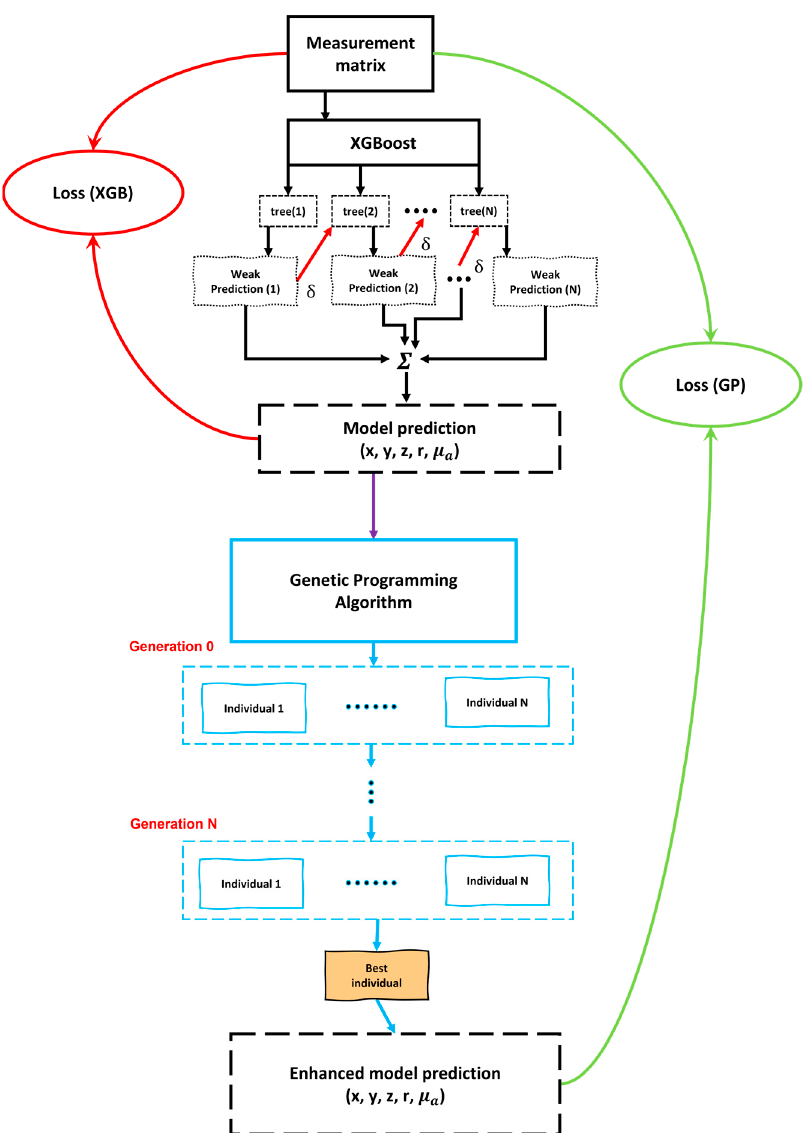
Figure 3. Schematic block diagram showing the workflow of the proposed methodology. The black and blue boxes show the working of the XGBoost and GP algorithms, respectively.